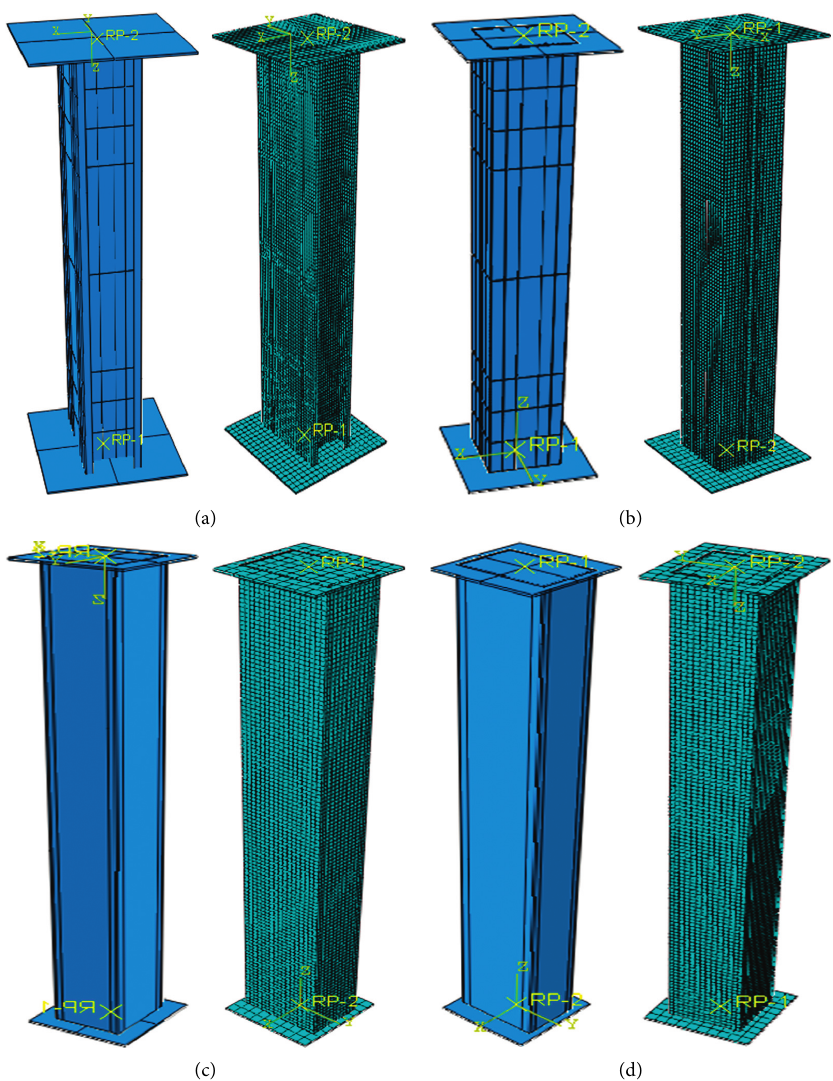
Figure 31: Load-axial displacement curve: (a) 4C series, (b) CU series, (c) CF series, and (d) ZF